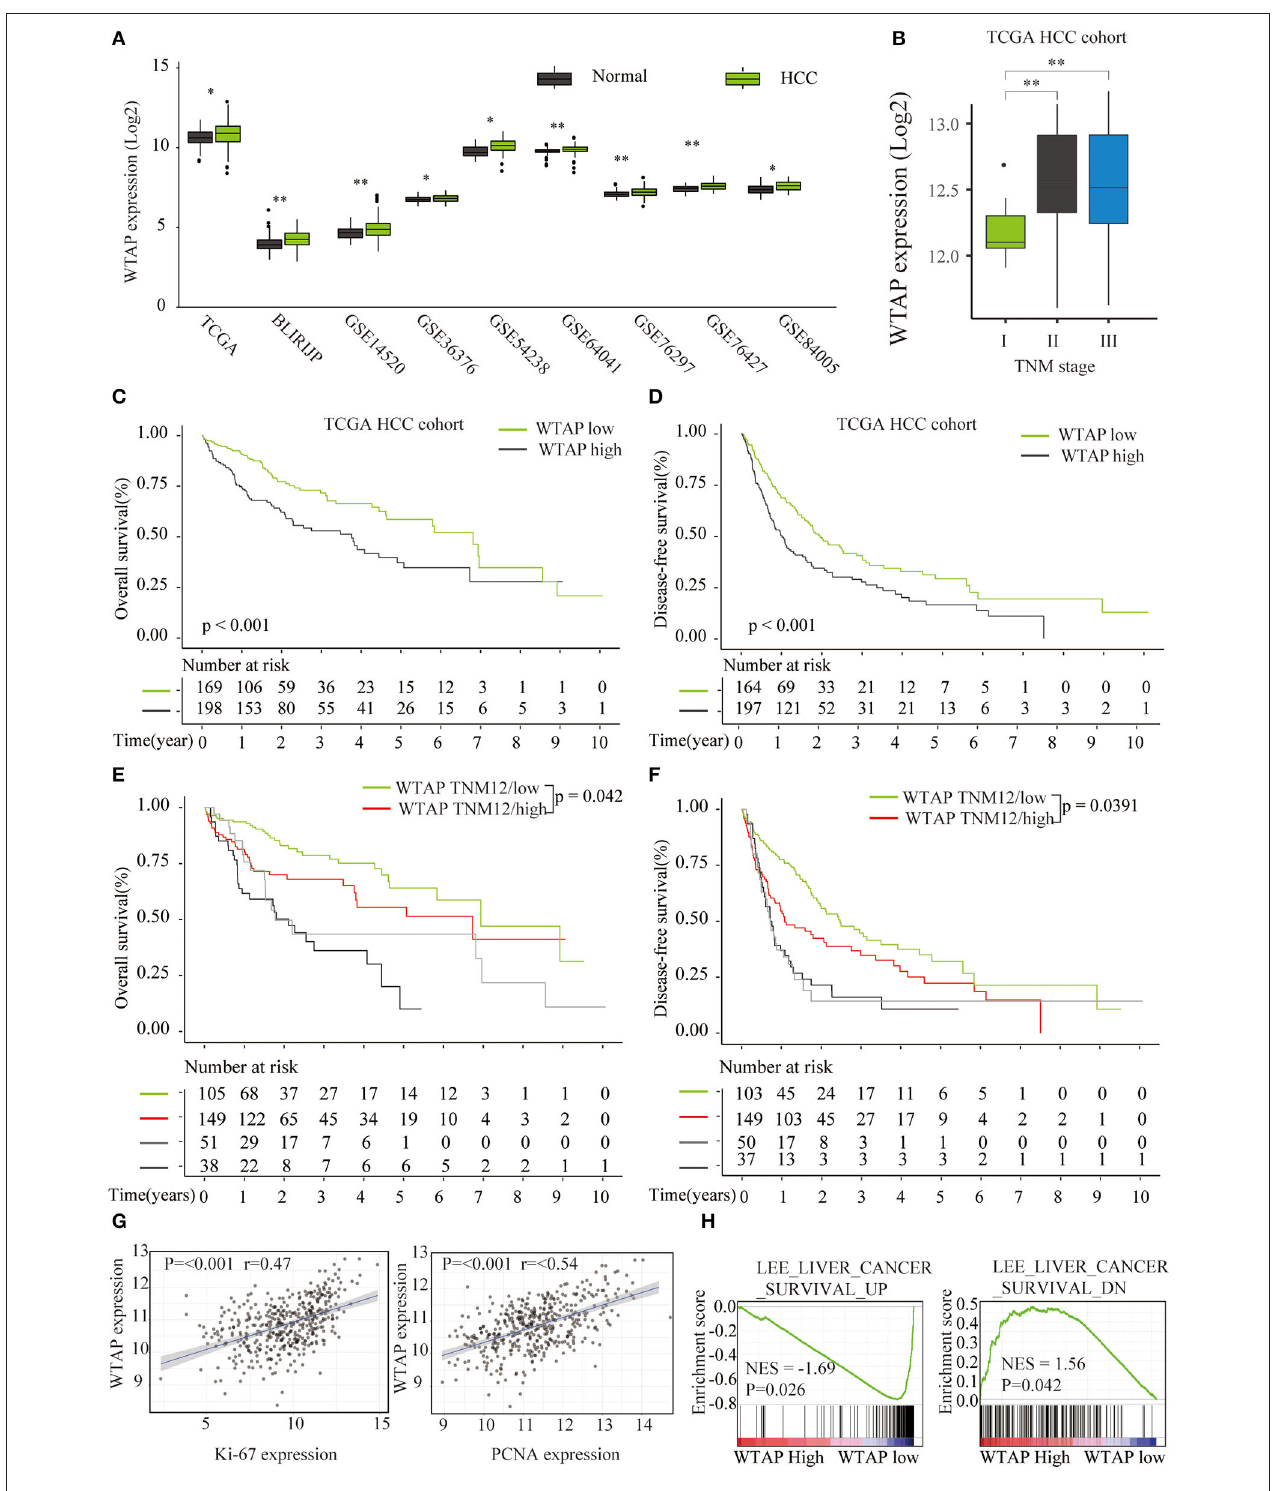
FIGURE 2 | Bioinformatics analysis of a correlation between an elevated WTAP expression and a poor survival of the patients with HCC in public databases. (A) Quantification of WTAP messenger RNA (mRNA) expression levels in patients with HCC in The Cancer Genome Atlas (TCGA) and Gene Expression Omnibus (GEO) data sets. (B) WTAP mRNA expression levels in HCC tissues with different Tumor-Node-Metastasis (TNM) stages based on a TCGA HCC cohort analysis. (C,D) A prognostic significance of the WTAP expression in patients with HCC was analyzed in the TCGA ( n = 367) database. (E,F) A prognostic significance of the WTAP expression in patients with HCC at different TNM stages was analyzed in the TCGA ( n = 367) database. (G) Pearson correlation analysis of WTAP expression levels with the Ki-67 or proliferating cell nuclear antigen (PCNA) expression in TCGA HCC data sets. (H) Gene set enrichment analysis (GSEA) of a correlation between the WTAP expression and gene signatures of the survival in HCC. * p < 0.05, ** p < 0.01 based on the non-parametric test.